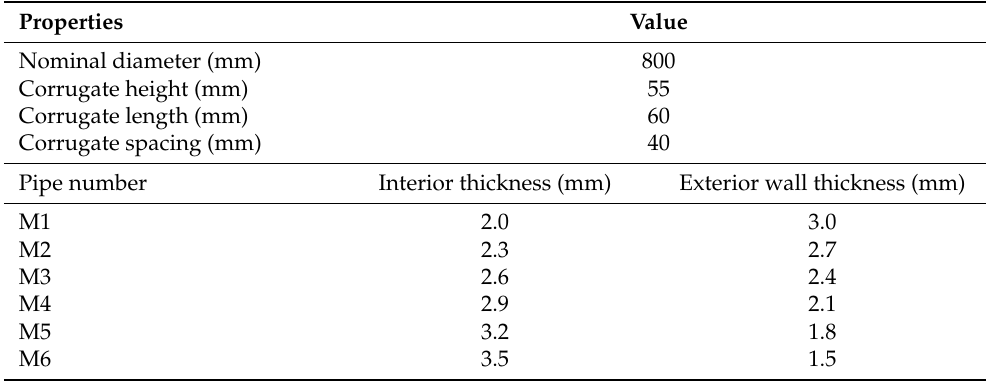
Table 3. Properties of pipes’ geometry.